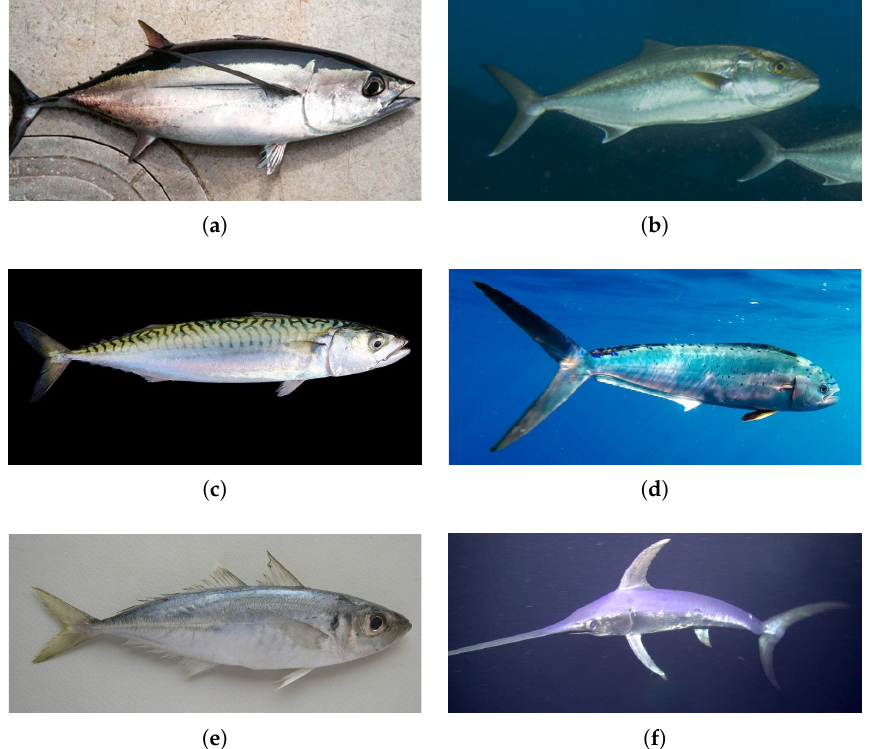
Figure 5. The six species of interest for the Symbiosis project considered in this work. ( a ) Albacore tuna ( Thunnus alalunga ). Photo credit: User:Pvmoutside, Public domain, via Wikimedia Commons. ( b ) Greater amberjack ( Seriola dumerili ). Photo credit: H. Nativ, Morris Kahn Marine Research Station. ( c ) Atlantic mackerel ( Scomber scombrus ). Photo credit: Hans Hillewaert, licensed with CC BY-NC-ND 2.0. ( d ) Dorado ( Coryphaena hippurus ). Photo credit: Uri Magnus Dotan. ( e ) Mediterranean horse mackerel ( Trachurus mediterraneus ). Photo credit: Fisheries Research Institute, CC BY-SA 4.0,